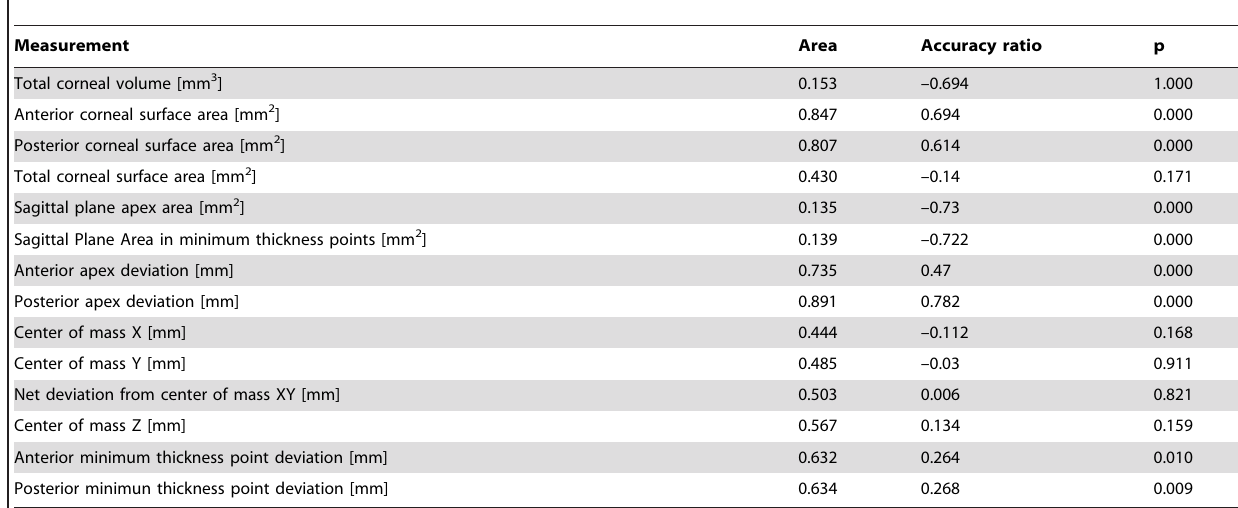
Table 4. ROC analysis of sensitivity versus 1-specificity in the disease diagnosis for proposed measurements.